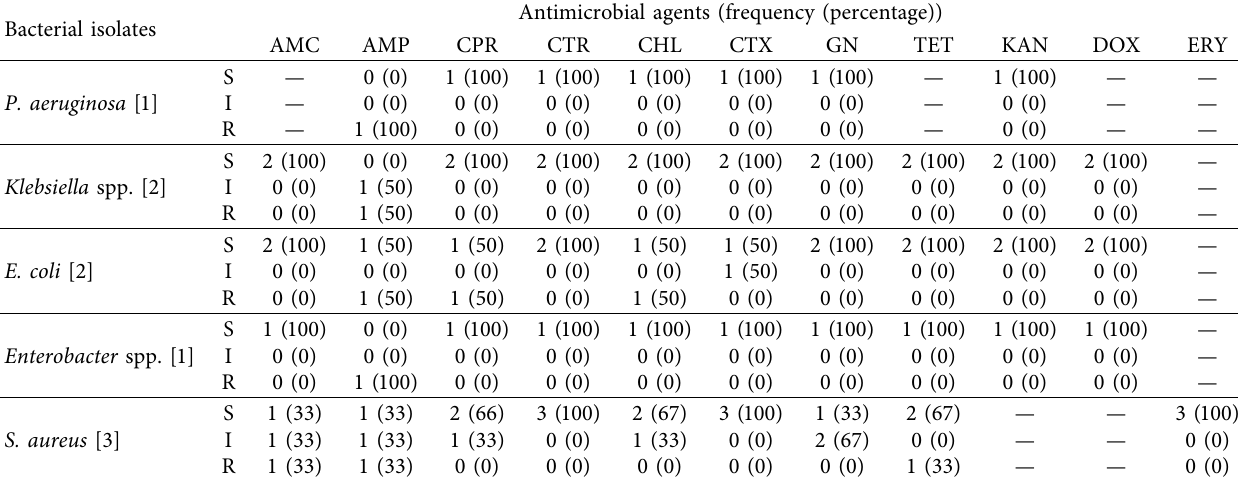
Table 4: Antibiotic susceptibility patterns of bacterial isolates from effluent released from Sikella Health Center. Bacterial